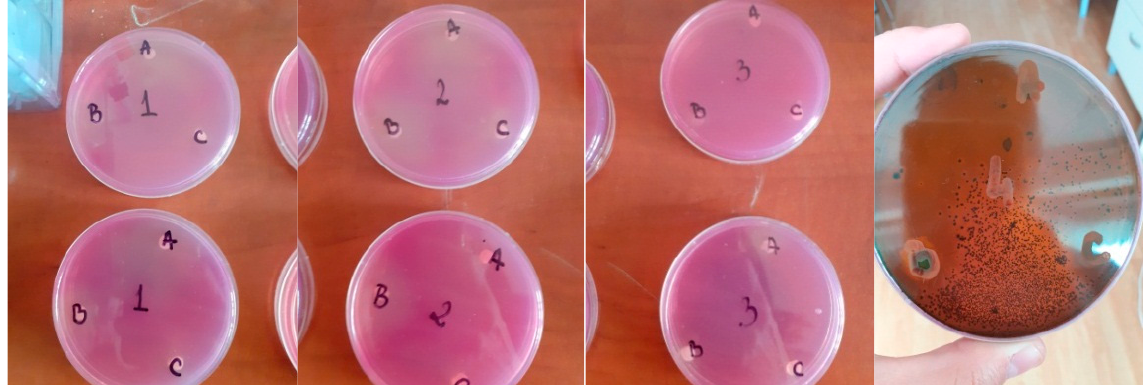
Figure 1. Zone of inhibition after 48 h: 1. Geotrichum candidum ; 2. Penicillium expansum ; 3. Aspergillus niger ; 4. Escherichia coli ; A. Lavender volatile oil; B. Mint volatile oil; C. Fennel volatile oil.